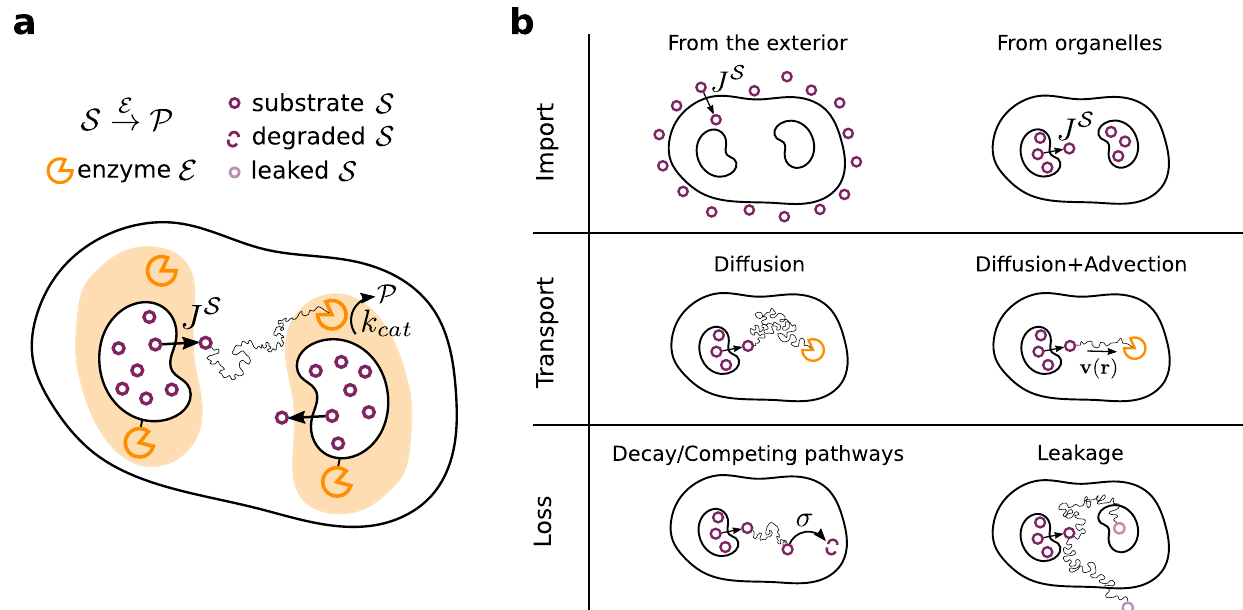
Fig. 1 Schematic representation of the class of models considered in this work. a An enzyme E converts a substrate S to product P with a catalytic rate k cat . The enzyme molecules can be freely placed, both within the system and on its interior or exterior membranes. b exterior or produced within internal compartments. b — Transport: Within the system, S is transported diffusively, and possibly also advectively via a velocity fi eld v ( r ), e.g., by active transport or cytoplasmic streaming. b — Loss: During transport, S can also be degraded with rate σ or leak out of the system via a